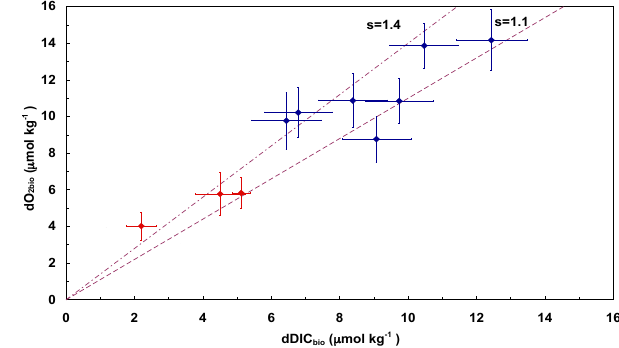
Figure 8. Measured changes (absolute values) of O 2 (µmolkg − 1 ) as a function of measured changes (absolute values) of DIC (µmolkg − 1 ) between consecutive mornings (dark blue dots) or dur- ing the daylight period (light blue dots). The slope of the black dot- ted line is 1.